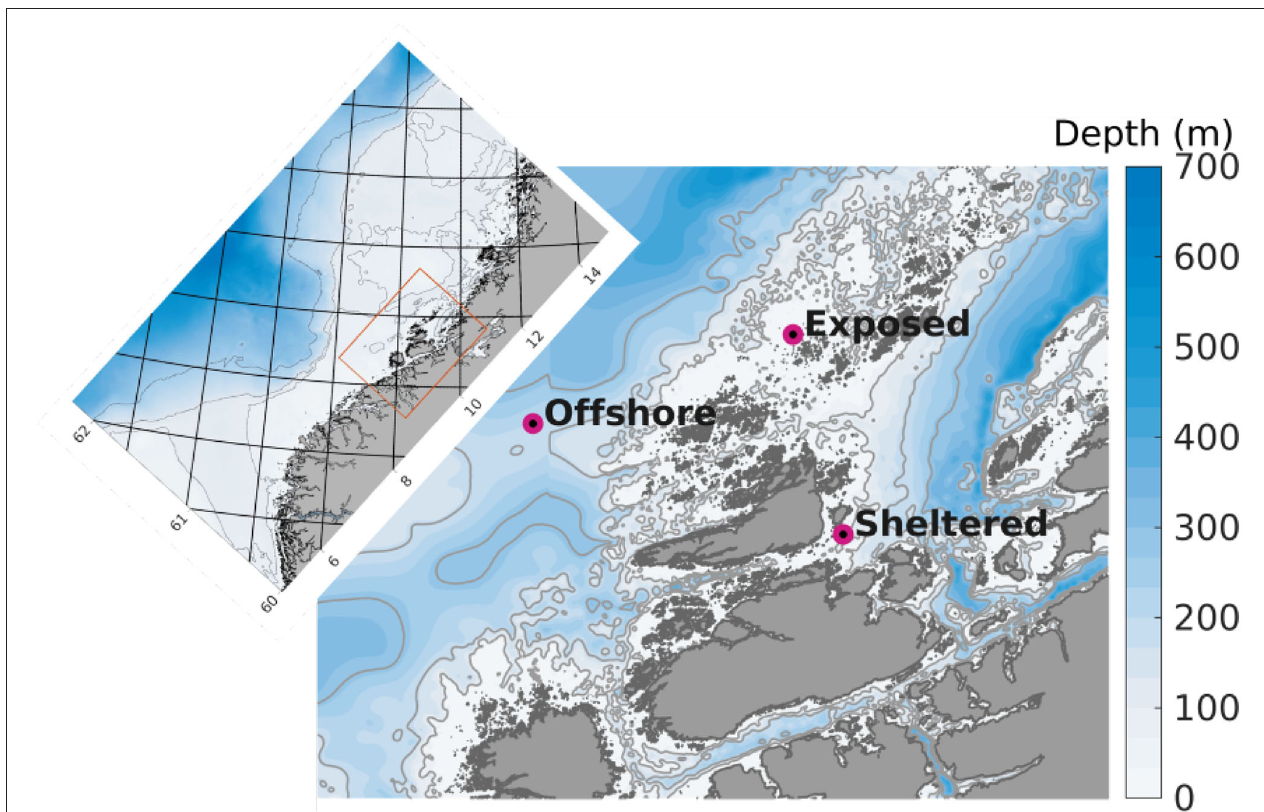
FIGURE 1 | Detail of the model domain in 160 m horizontal resolution used for the dispersal simulations. The purple dots indicate the positions of the release sites. The colors indicate bottom depth (m), and the thin gray curves represent the 100, 200, and 300 m isobaths. The inset map displays the 800 m model domain that was used to generate boundary conditions for the 160 model (orange rectangle in inset map). The numbers along the axes denote latitude and